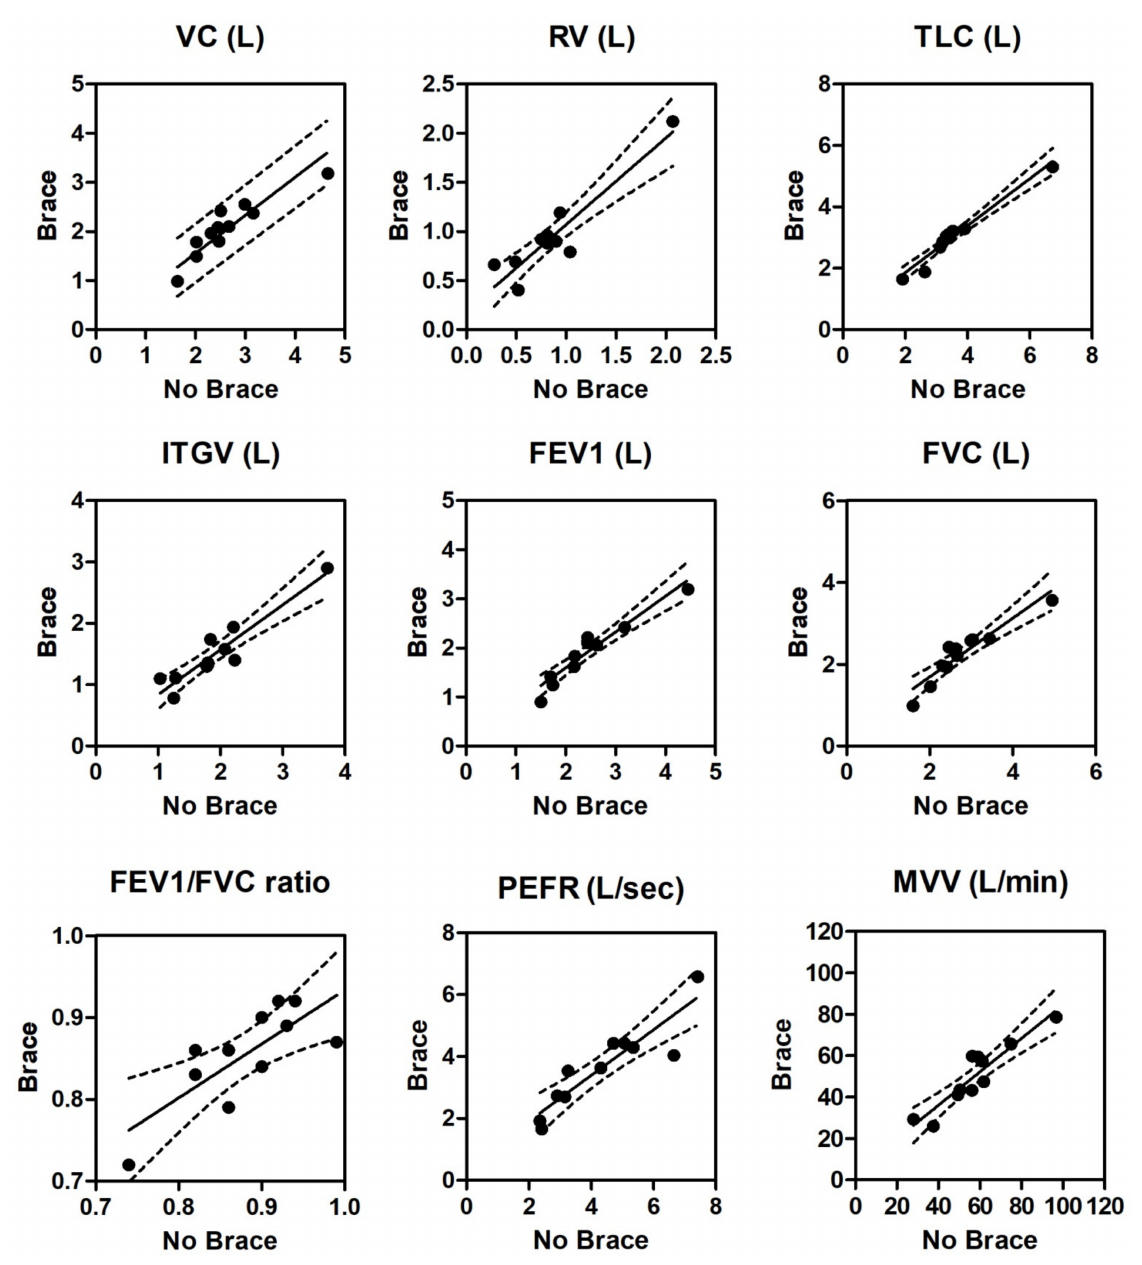
Figure 1. Scatter diagrams and regression lines (dashed lines are 95% CIs) for lung volumes and other respiratory parameters at baseline (x axis) and immediately after wearing the Sforzeso thoracolumbar brace (y axis). VC is vital capacity, RV residual volume, TLC total lung capacity, ITGV intrathoracic gas volume, FEV1 forced expiratory volume for 1 s, FVC forced vital capacity, FEV1/FVC ratio, PEFR peak expiratory flow rate, and MVV maximal voluntary ventilation. Correlation was significant at p < 0.0001 for each set of measurements, except FEV1/FVC ratio ( p = 0.0054). Correlation coefficients and regression equations for each parameter set are seen in the Appendix A (Table